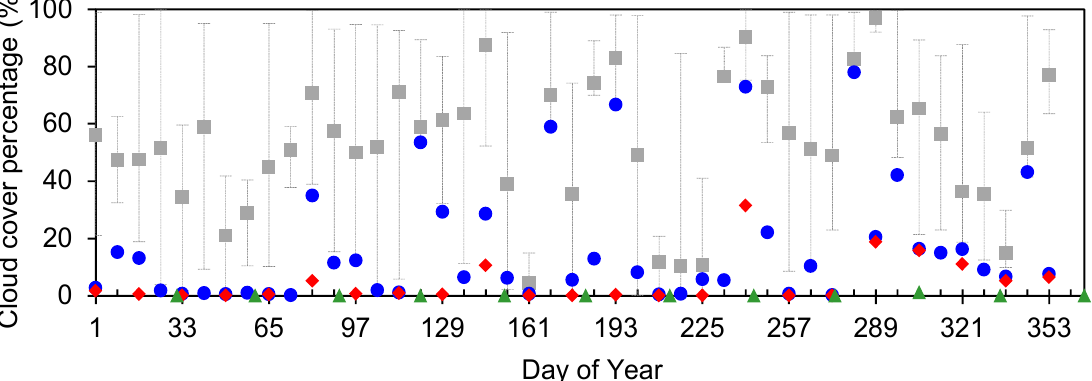
Figure 4. Comparison of cloud cover percentage before and after the temporal composition. The grey blocks with the grey bar were the average cloud cover percentage and its maximum and minimum value in the 8-day compositing period. The blue rounds, red diamonds and green triangle points were the residual cloud cover percentage of the 8-day, 16-day and monthly composites, respectively.